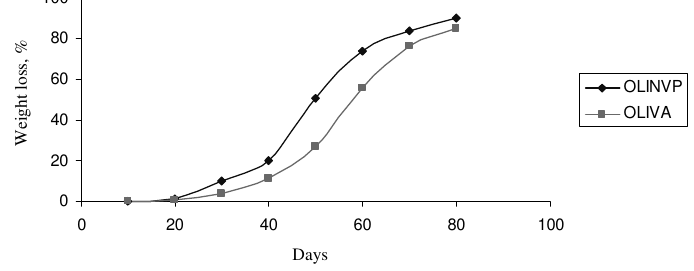
Figure 11. Analysis of soil burial